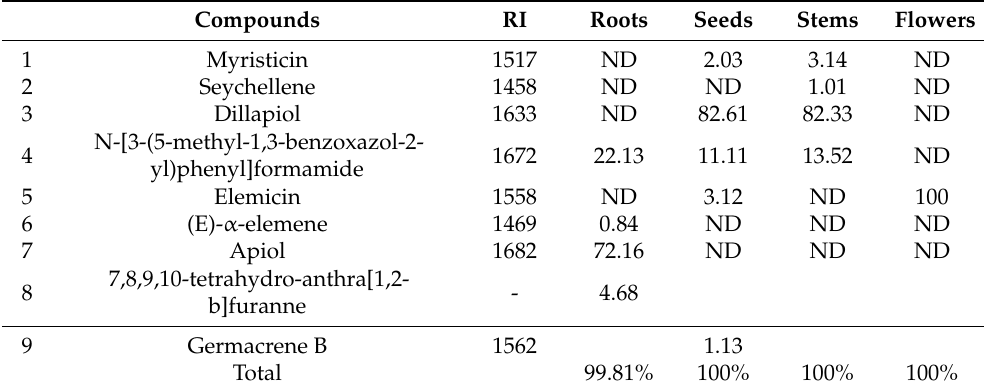
Table 2. Chemical composition of four parts of D. triradiata Hochst. ex Boiss essential oil from the Northern region of Saudi Arabia. Compounds RI Roots Seeds Stems